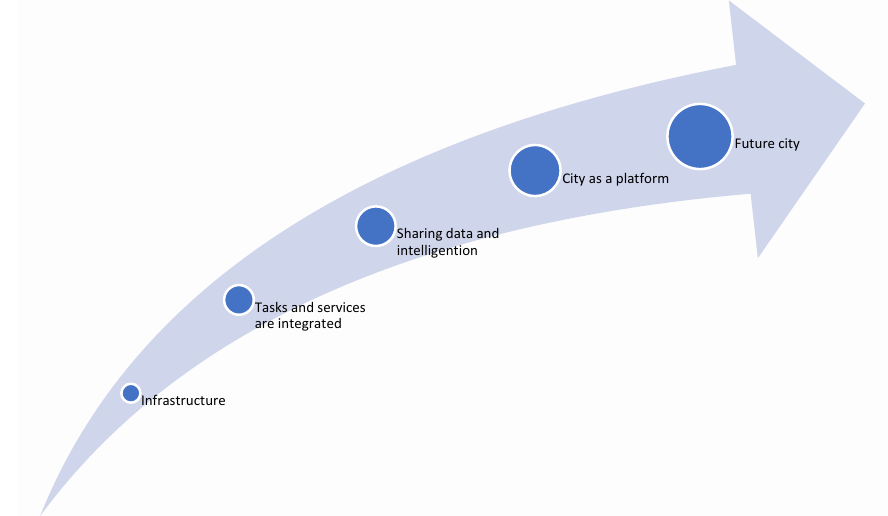
Figure 5. Five-step smart city perspective model. Source: made by authors. Combining the wide range of approaches and relevant data, Lee M . et al. in 2018 show an exact case of smart city evolution to self-organize smart city 4.0 from the perspec- tive of open innovation as a step to be implemented today [27]. However, new studies (2021) already have proposed Smart City 5.0 as an urban ecosystem of smart services based on a decision-making digital platform. The same concept follows the research (2022)